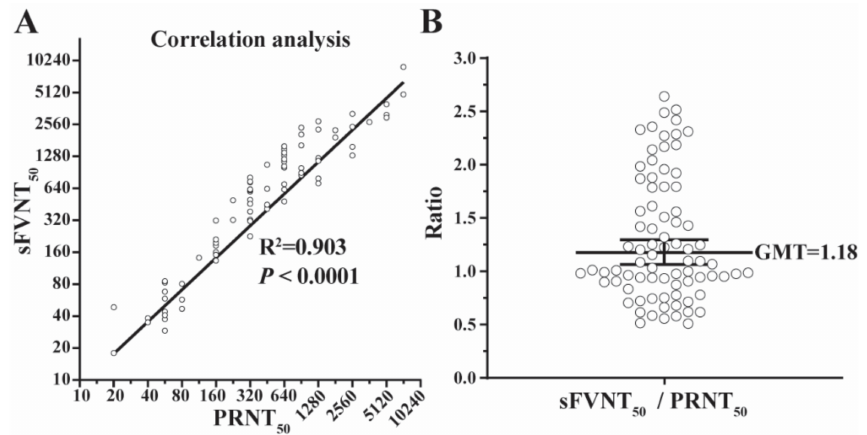
Figure 3. The correlation of the SFVNT 50 versus PRNT 50 . ( A ) The correlation between the SFVNT 50 and the conventional PRNT 50 . Eighty human serum/plasma samples were tested by the SFVNT and PRNT, respectively. Pearson’s correlation coefficient and P-value (two-tailed) are indicated. ( B ) The ratio of the SFVNT 50 to PRNT 50 . The geometric mean (GM) of the ratios from 80 samples is indicated. The error bar shows the 95% confidence interval of GM.